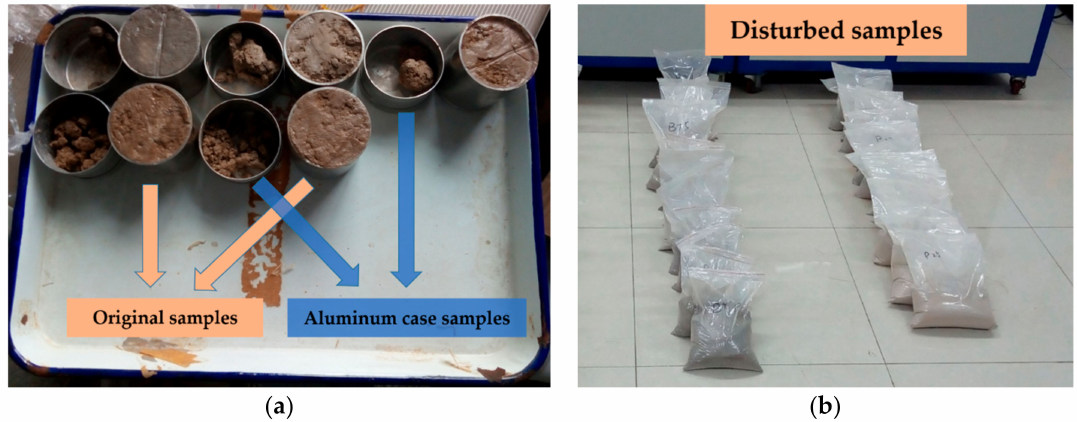
Figure 2. ( a ) Original and aluminum case soil samples and ( b ) disturbed soil